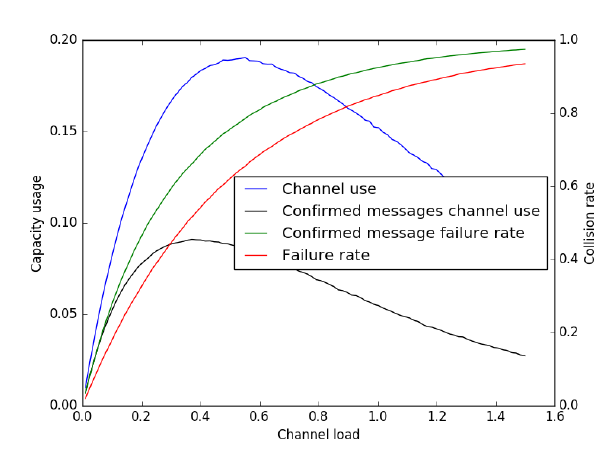
Figure 11. Link capacity usage and packet collision rate for a LoRaWAN network when using confirmed messages. The load is as defined in Section